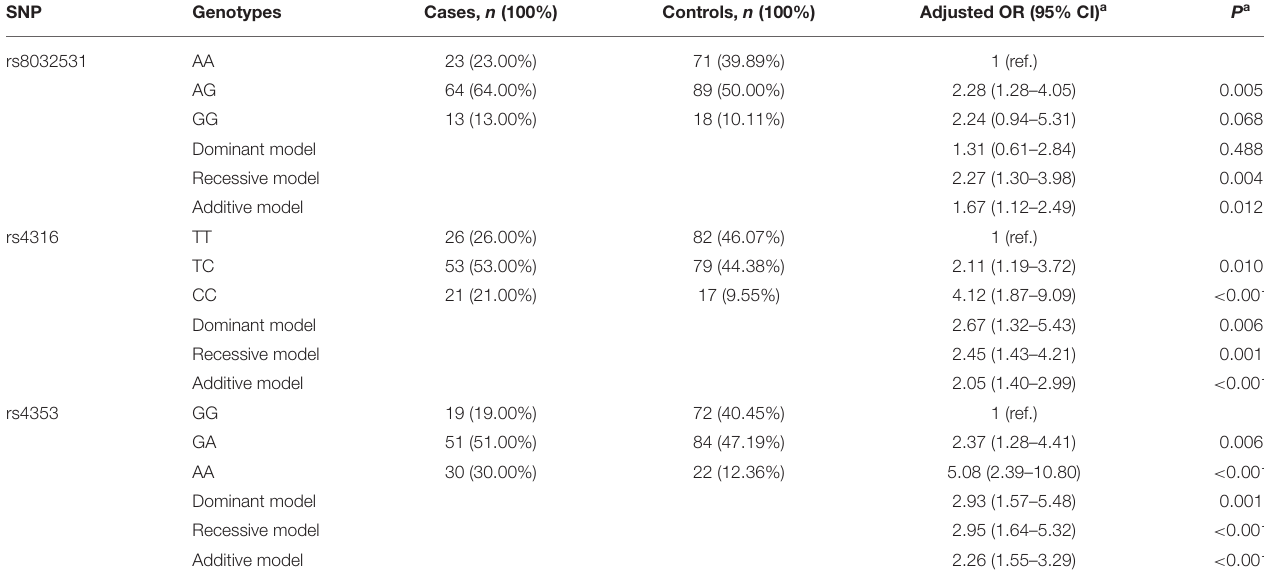
TABLE 4 | Association of 3 significant SNPs with MPP risk under different genetic models. SNP